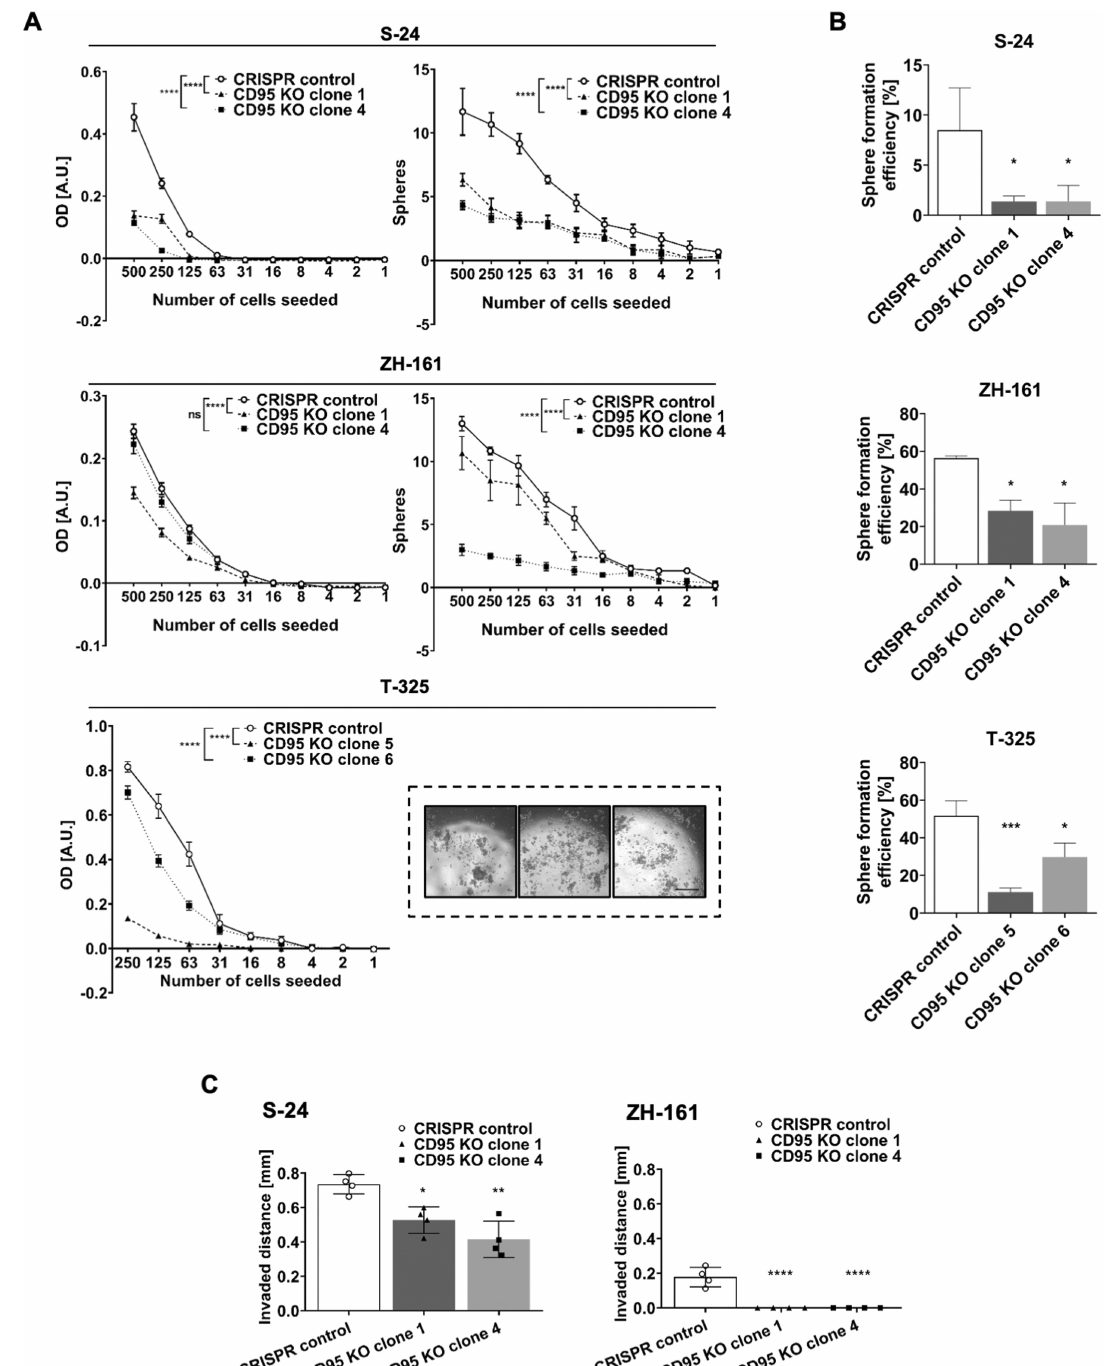
Fig. 4 Effect of CD95 CRISPR knockout (KO) on human GIC growth, spherogenicity and invasion in vitro. A The clonogenic growth and sphere formation capacity of S-24, ZH-161, and T-325 cells were evaluated by their end-point metabolic activity as measured by MTT-based quanti fi cation and by sphere counting in limiting dilution assays. Data in A are expressed as mean and SEM of representative experiments. Statistical signi fi cances were determined by means of a two-way ANOVA test followed by Bonferroni ’ s post hoc test (main column effect). B Sphere formation ef fi ciency upon single-cell seeding was calculated as the number of spheres counted/number of seeded cells. Data in B are expressed as the mean and SD of three experiments. C The invasion capacity of CRISPR control or CD95 KO S-24 or ZH-161 cells was assessed by means of collagen invasion assays. Invaded distances from the spheroid center were quanti fi ed. Data in C are expressed as the mean and SD of a representative experiment. Statistical signi fi cances in B , C were determined by a one-way ANOVA test followed by Bonferroni ’ s post hoc test. Data in A – C were reproduced in three independent experiments. * p < 0.05, ** p < 0.01, *** p < 0.001, **** p < 0.0001, ns not signi fi cant versus CRISPR control cells; A.U., arbitrary units; Inset scale bar = 500 μ m.